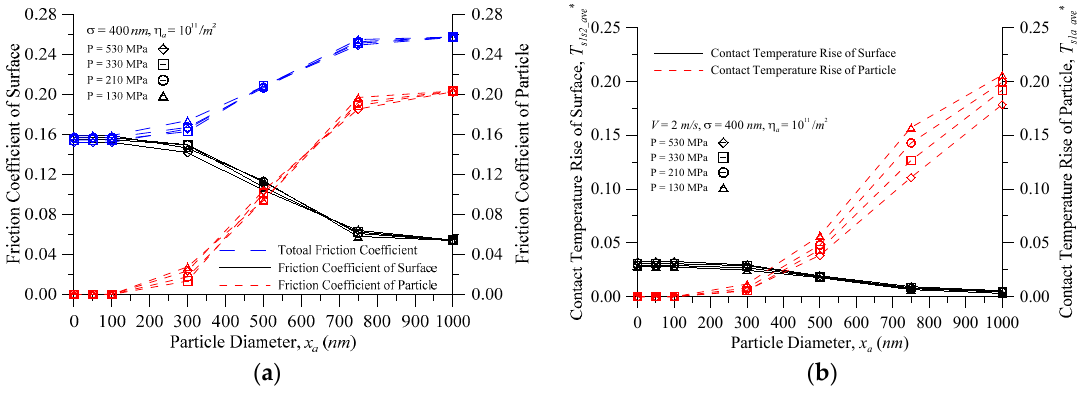
Figure 6. The characteristics of the surface and particle vs. the particle diameter at various contact pressures for ( a ) the coefficient of friction; and ( b ) the contact temperature rise.